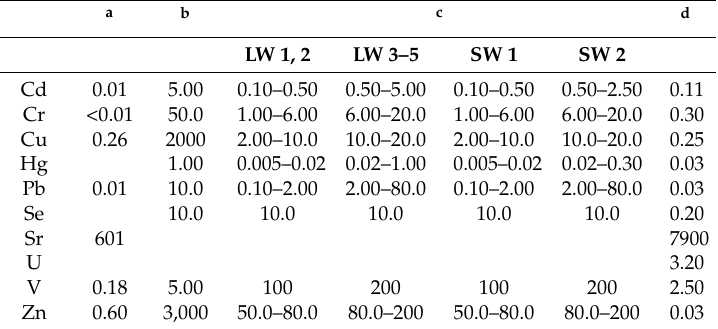
Table 3. Published values of trace elements in natural water according to Croatian legislative levels of water pollutants [48] a , from a Croatian karst locality [54] b , and [55] c (LW—land water: 1—no pollution, 2—element values are not significantly higher than natural ones, 3—element values are lower than constant toxic levels, 4—element values are periodically higher than constant toxic levels, without causing constant toxic conditions, and 5—element values are higher than constant toxic levels, causing acute toxic conditions; SW—seawater: 1—coastal sea, 2—sea directly affected by pollution from land and islands), and average world seawater [25] d (all in µ g/L).